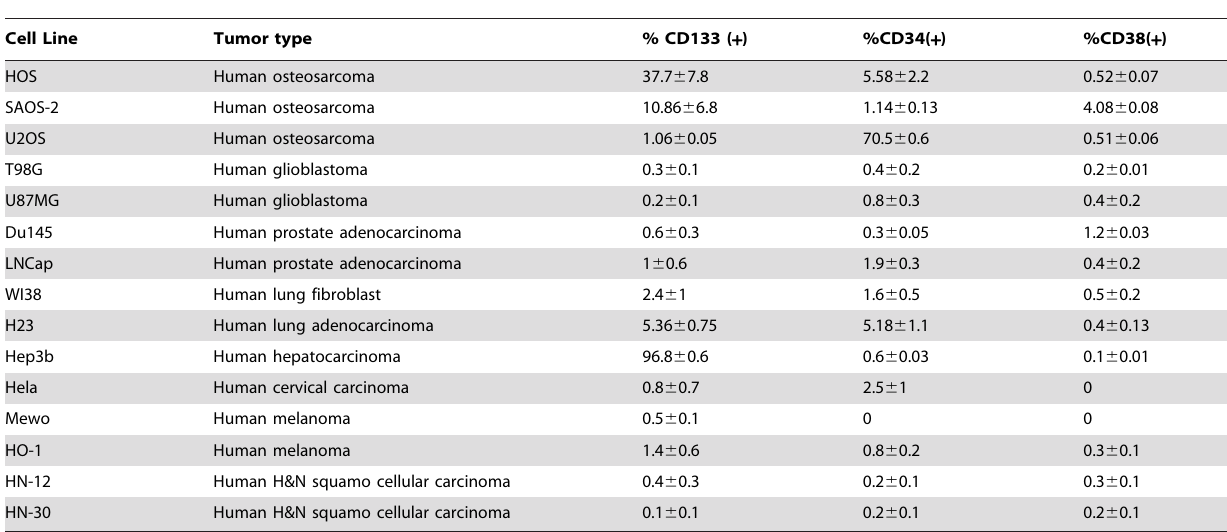
Table 1. Percentage of positivity 6 standard deviation to CD133 of the various cell lines tested.